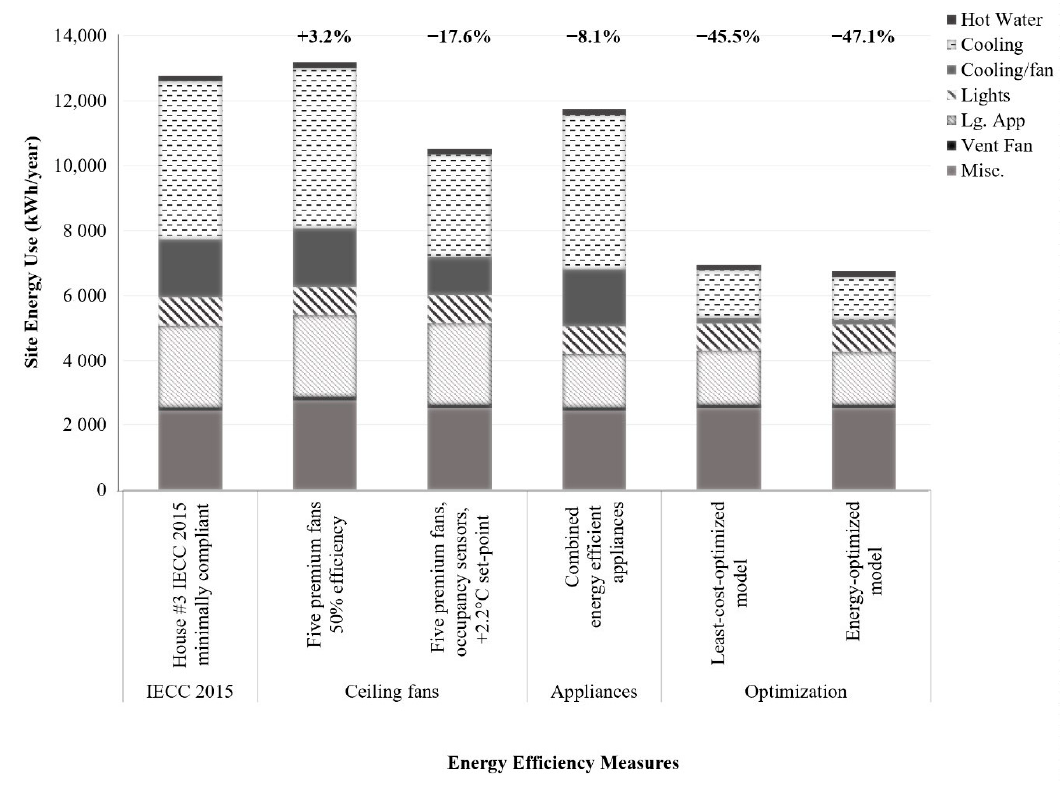
Figure 5. Simulated annual site energy (kWh / year) consumption for ceiling fans, appliances, and the Figure5 optimized models vs. the IECC 2015 baseline. Percent changes in annual energy use are labeled.